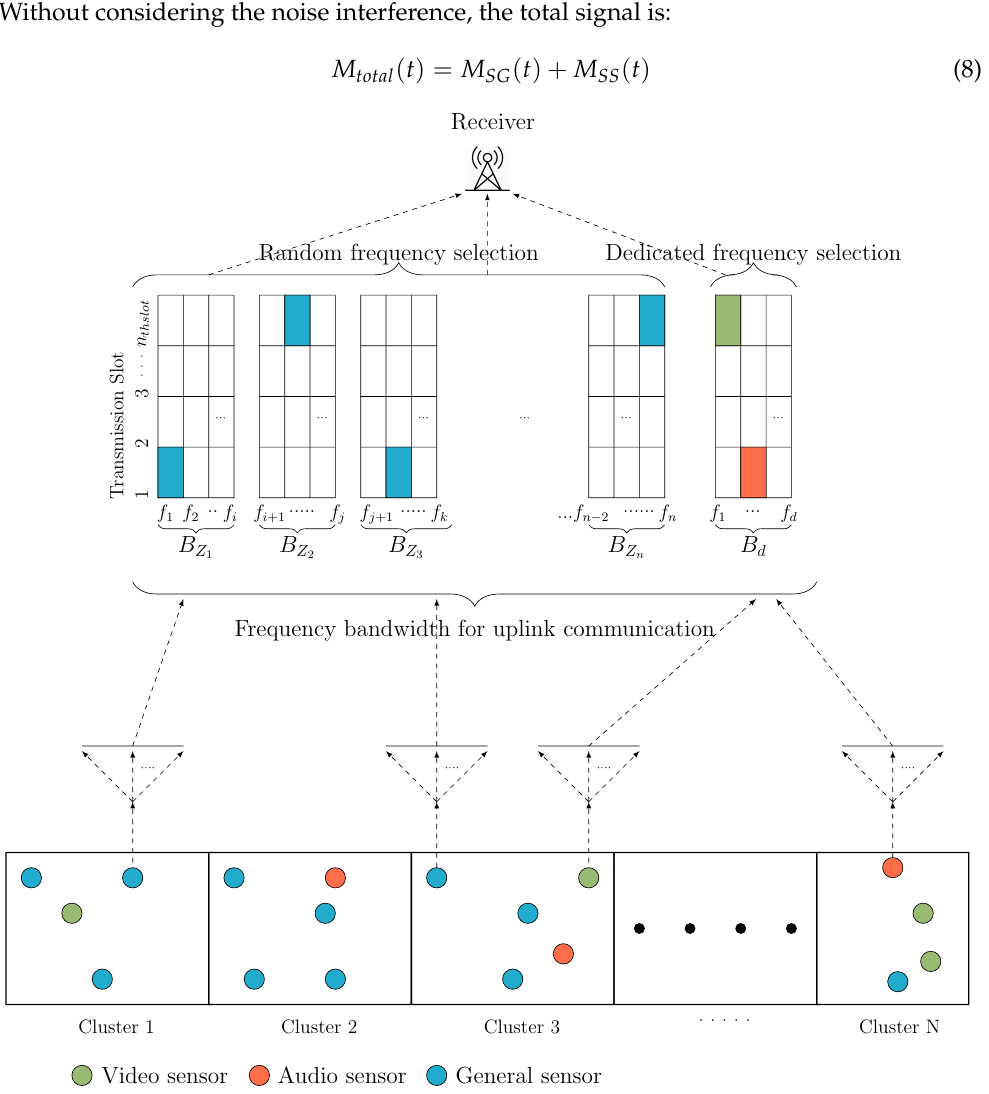
Figure 2. System